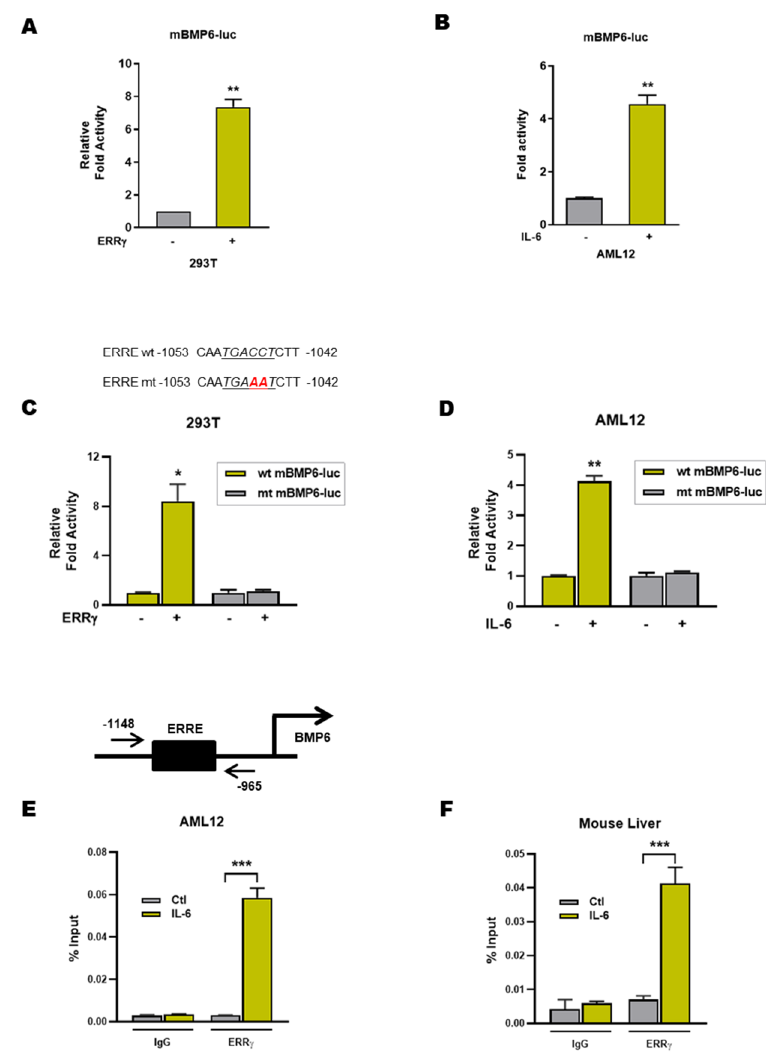
Figure 4. ERR γ activates mouse BMP6 gene promoter activity. ( A ) 293T cells were transfected with a mouse BMP6 promoter-luciferase reporter construct (mBMP6-luc) along with pcDNA3.1 empty vector or pcDNA-ERR γ expression plasmid. ( B ) AML12 cells were transfected with mBMP6-luc and stimulated with IL-6 (20 ng / mL) for 12 h. ( C ) 293T cells were transfected with wild type or ERRE mutant mBMP6-luc along with the ERR γ expression vector. ( D ) AML12 cells were transfected with wild type or ERRE mutant mBMP6-luc and stimulated with IL-6 (20 ng / mL) for 12 h. ( E ) ChIP assay showing binding of ERR γ to the BMP6 gene promoter. AML12 cells were treated with IL-6 and soluble chromatin was immuno-precipitated with an ERR γ antibody. Purified DNA samples were used for quantitative PCR with primers corresponding to the ERRE region of the mouse BMP6 gene promoter. ( F ) In vivo ChIP assay, showing binding of ERR γ to the BMP6 gene promoter in response to IL-6. We treated C57BL6 / J mice with IL-6 and immuno-precipitated soluble chromatin from mice livers with an ERR γ antibody. Purified DNA was used for quantitative PCR analysis with primers corresponding to the ERRE region of the mouse BMP6 gene promoter. Data are represented as mean + SEM. Asterisks indicate that the di ff erence between the groups was significant, as determined by two-tailed unpaired Student’s t -test. * p < 0.05, ** p < 0.01, *** p <